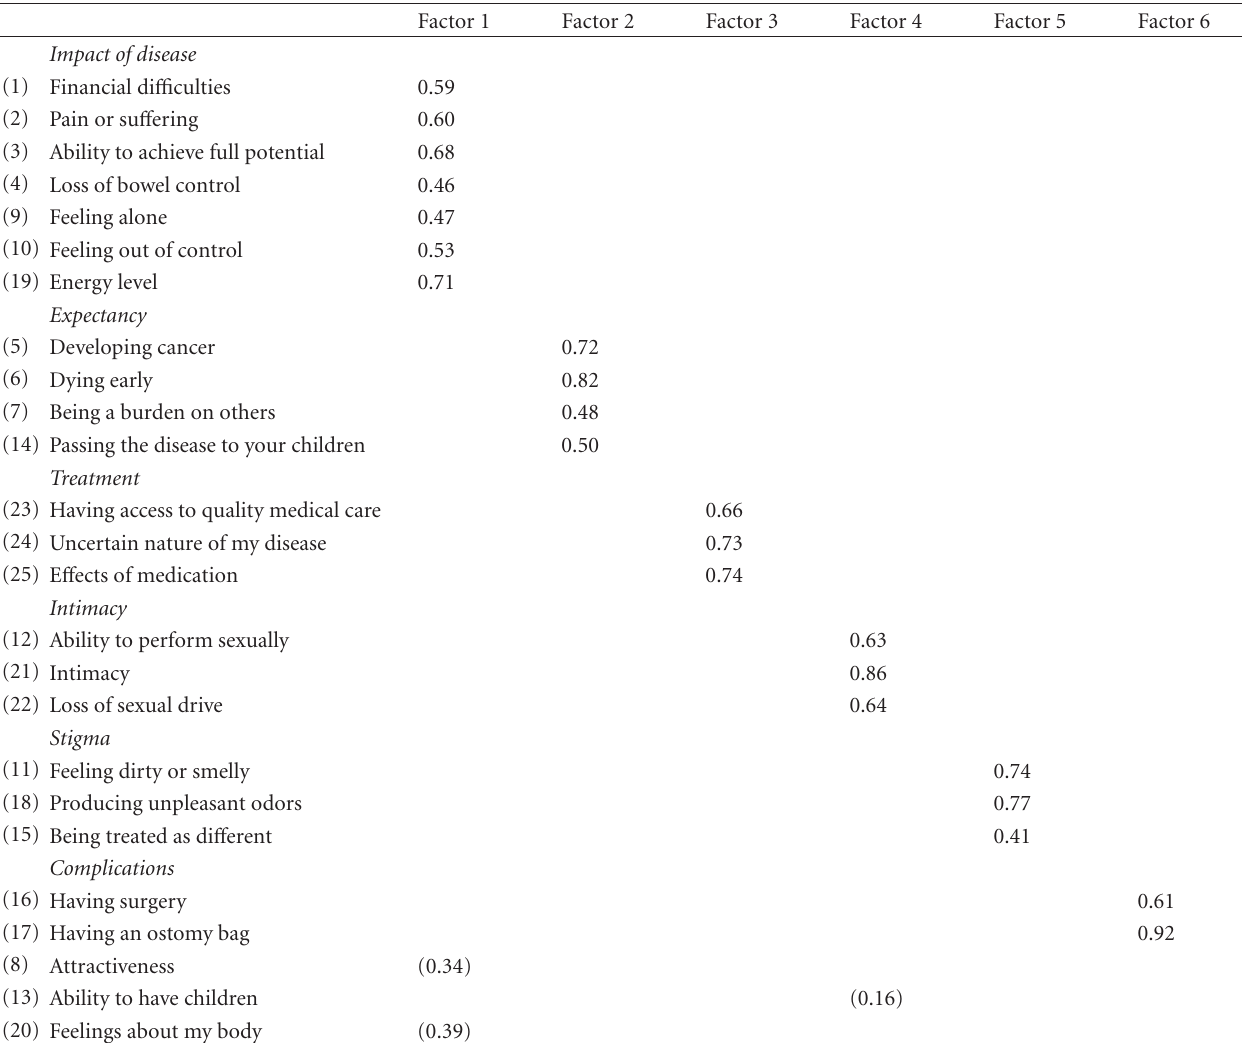
Table 4: Factor analysis of the RFIPC using maximum likelihood